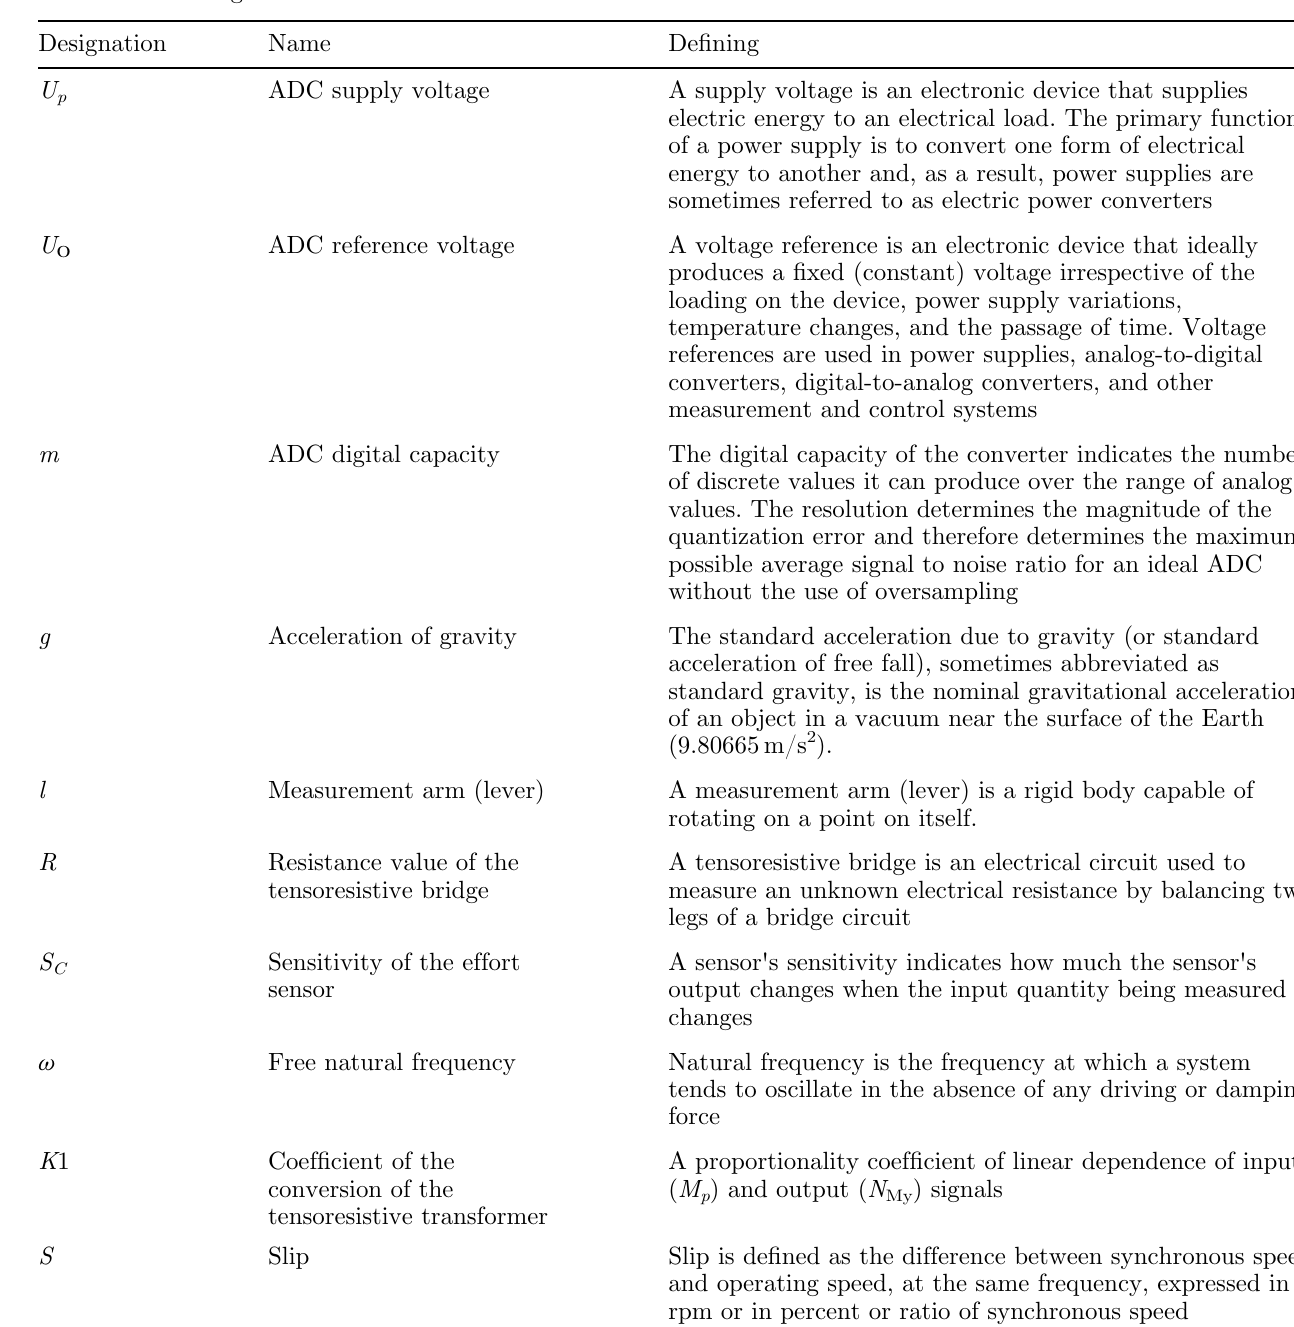
Table 1. De fi ning the